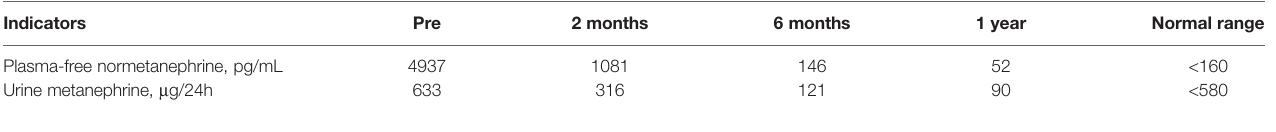
TABLE 1 | Biochemical laboratory fi ndings before and after 125 I seed implantation.